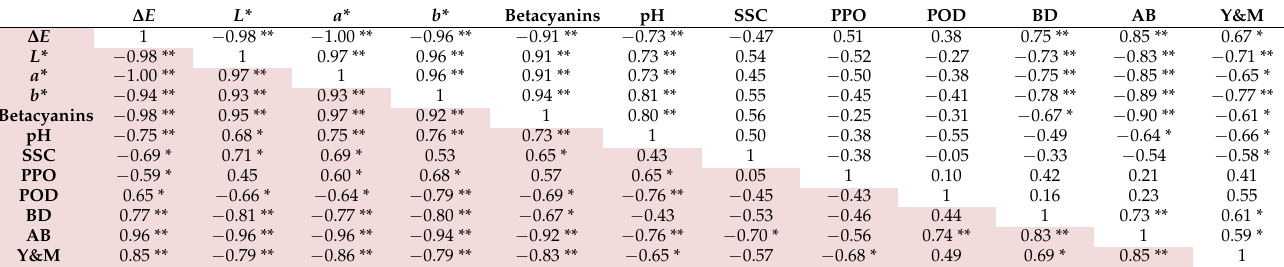
Table 1. Pearson correlation of microbial and quality parameters of thermosonication- (with gradient pink background) and thermal-treated clear red pitaya juice during